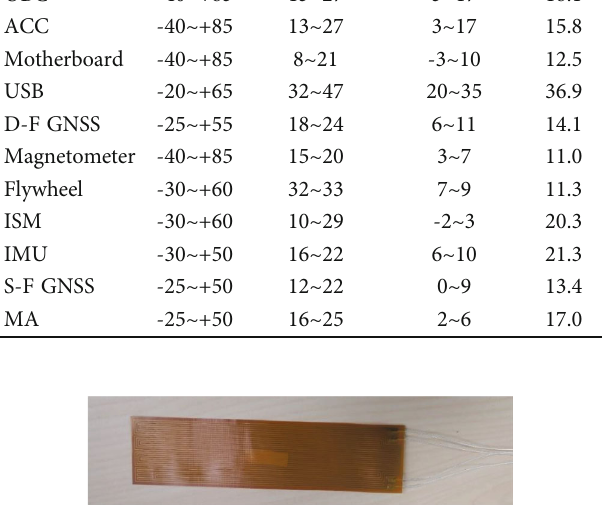
Figure 8: The electric heater of polyimide fi lm